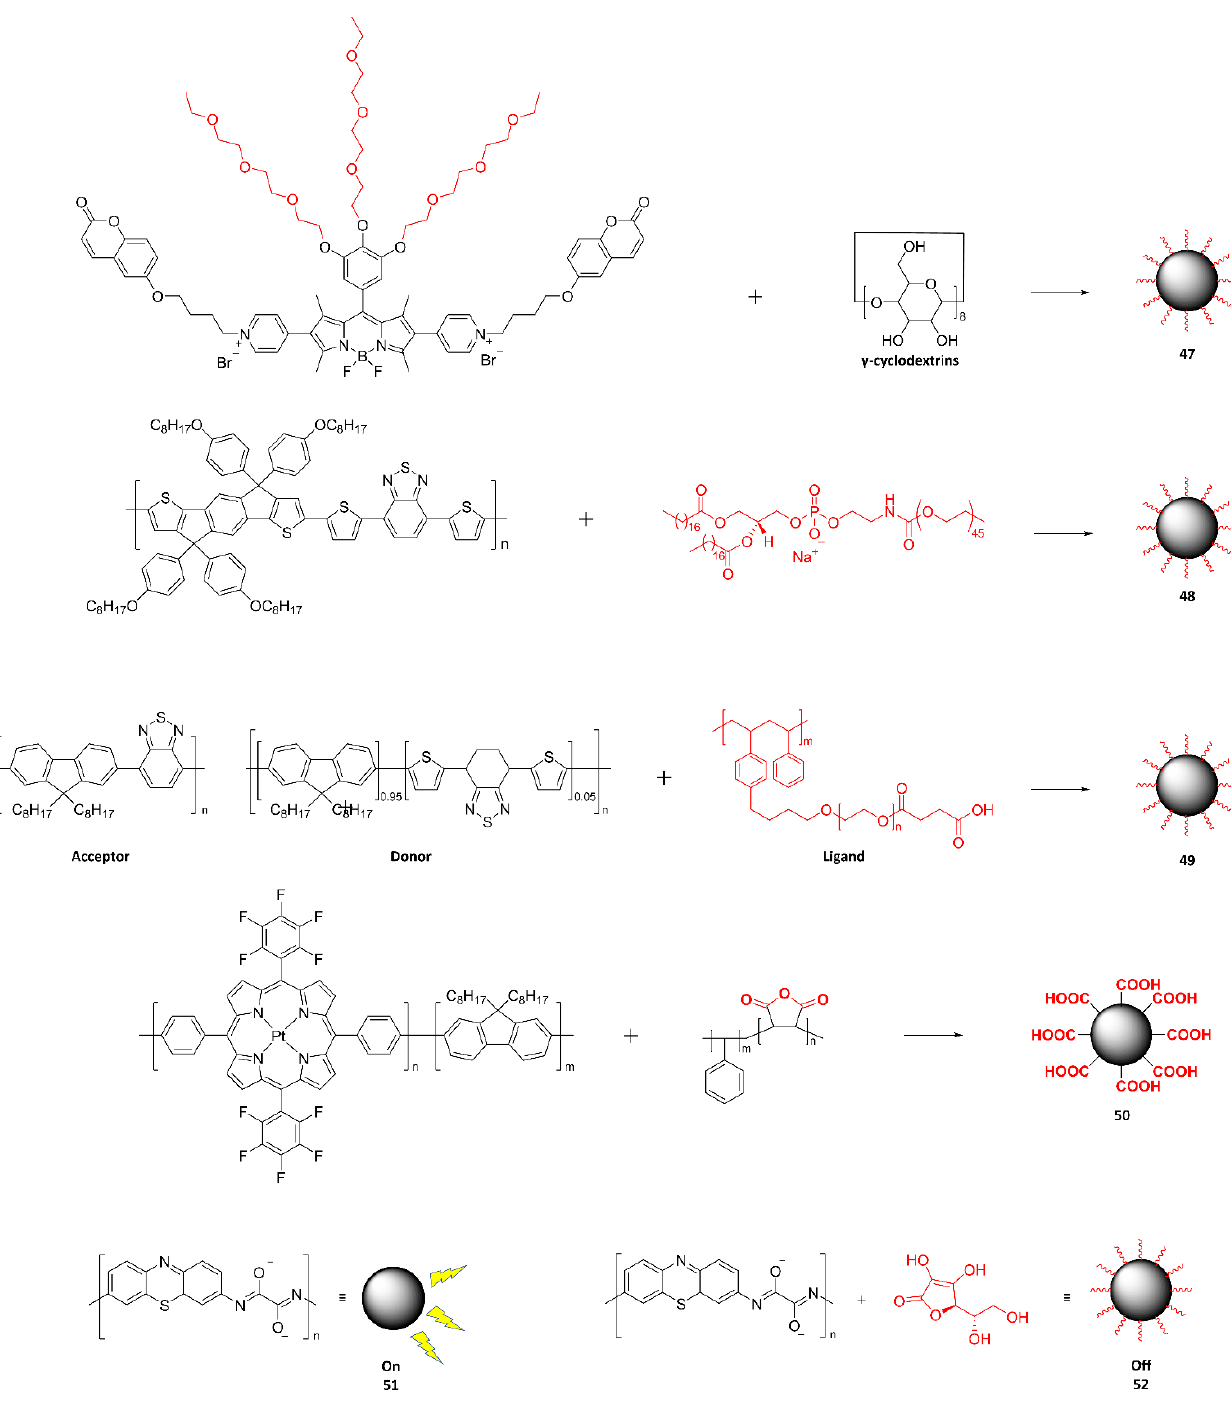
Figure 16. Chemical structures of the polymer probes constituting polymer dots when over two molecules are used. Table 5. Summary of the optical properties of photoluminescence polymer dots (Pdots) used for bioimaging.